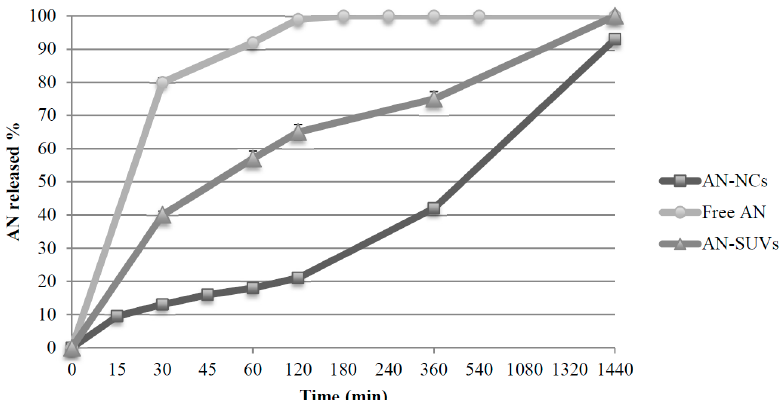
Figure 6. In vitro release profiles of free AN, AN–NCs and AN–SUVs in PBS. AN solution and AN–SUVs were tested to evidence the superiority of AN–NCs on the gradual release of AN. The data are displayed as the mean ± SD; n = 3.